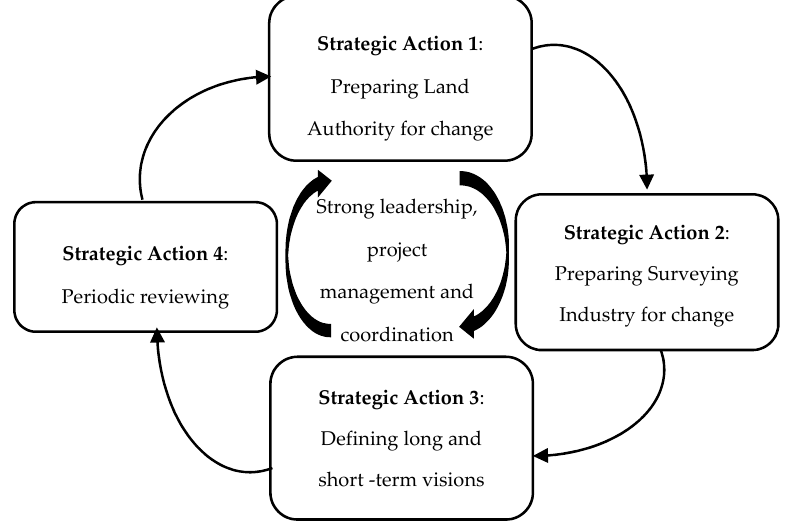
Figure 3. A framework of strategic actions to increase the adoption of the submission of digital cadastral data.